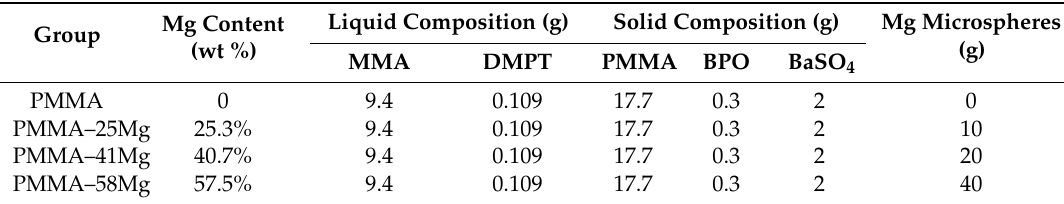
Table 1. Groups and compositions of cement